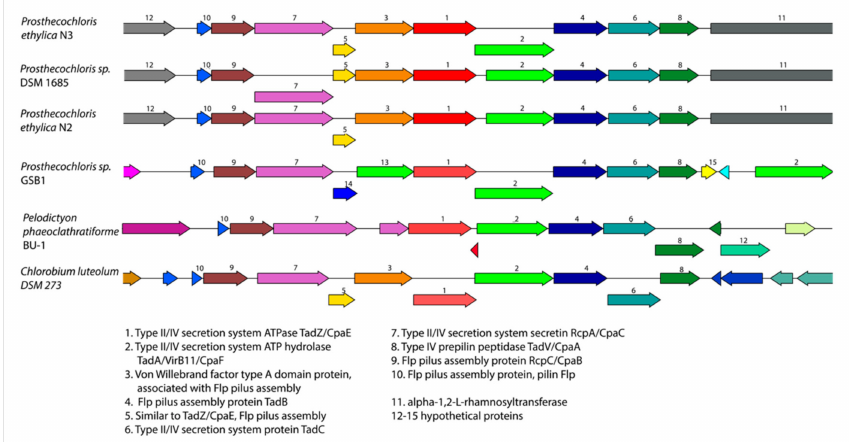
Figure 3. Gene cluster organization and synteny comparison of the Tad (Tight Adhesion) genes identified in the Prosthecochloris genomes. Genes are colored according to protein family (PGFam). Tad pili gene clusters encode a macromolecular transport system (type II secretion